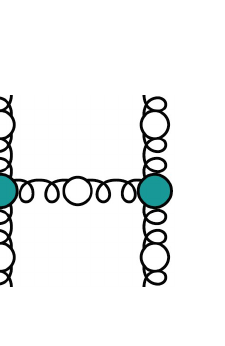
Panel ( A ): primitive gluon H -diagram. Panel ( B ): one- H -diagram contribution to quark+antiquark scattering. Legend: Dressed gluon two-point function—spring with open cir- cle insertion; dressed quark two-point function—straight line with open circle insertion; blue-filled circle at 3-gluon junction—dressed 3-gluon vertex; red-filled circle at gluon–quark junction—dressed gluon–quark vertex. Repeated insertion of H -diagrams within H -diagrams, exploiting both gluon– quark and gluon self-couplings, leads to a plaquette-like area-filling structure, reminiscent of the planar summation of elementary squares in